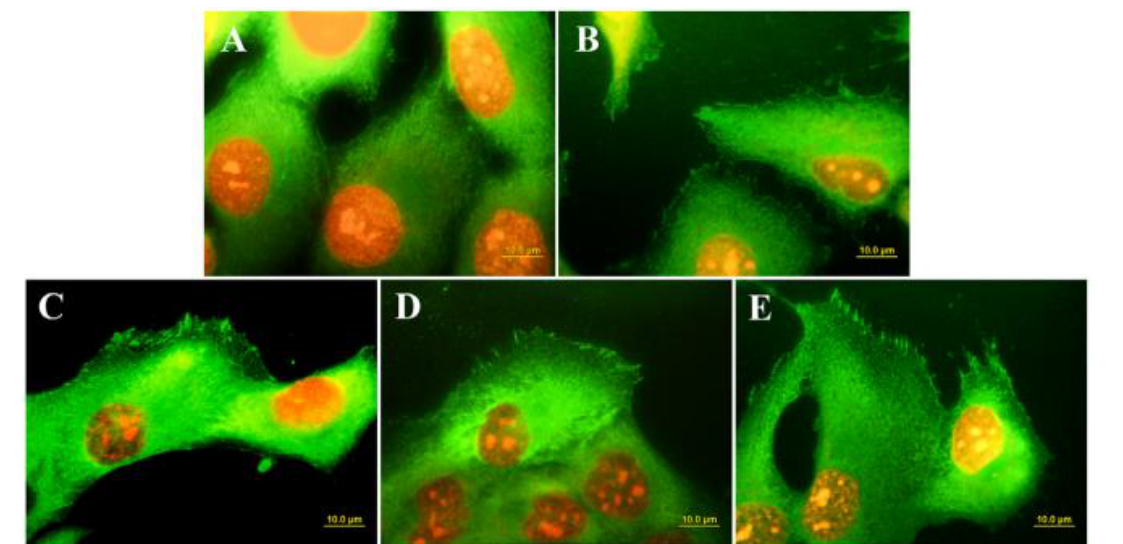
Figure 7. Immunofluorescence staining of talin in MG 63 cells on day 3 after seeding on microscopic glass coverslips ( A ), undoped nanocrystalline diamond ( B ), nanocrystalline diamond doped with Boron at various concentrations: 133 ppm ( C ); 1000 ppm ( D ); 6700 ppm ( E ). (From Ref. [109]).